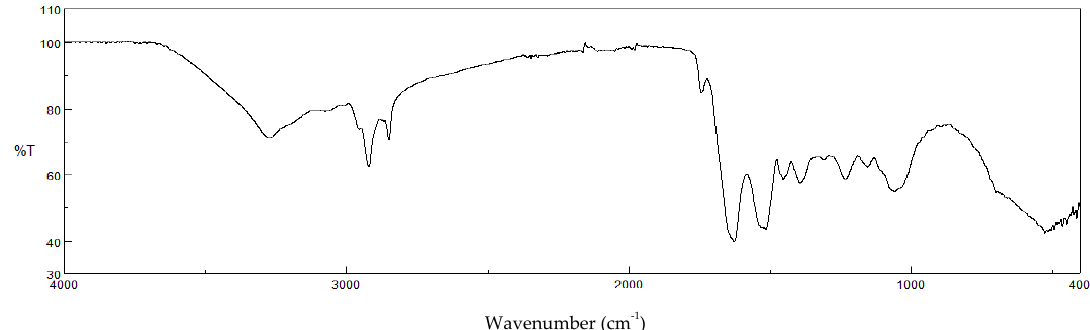
Figure 2. FTIR spectra of SD crickets.